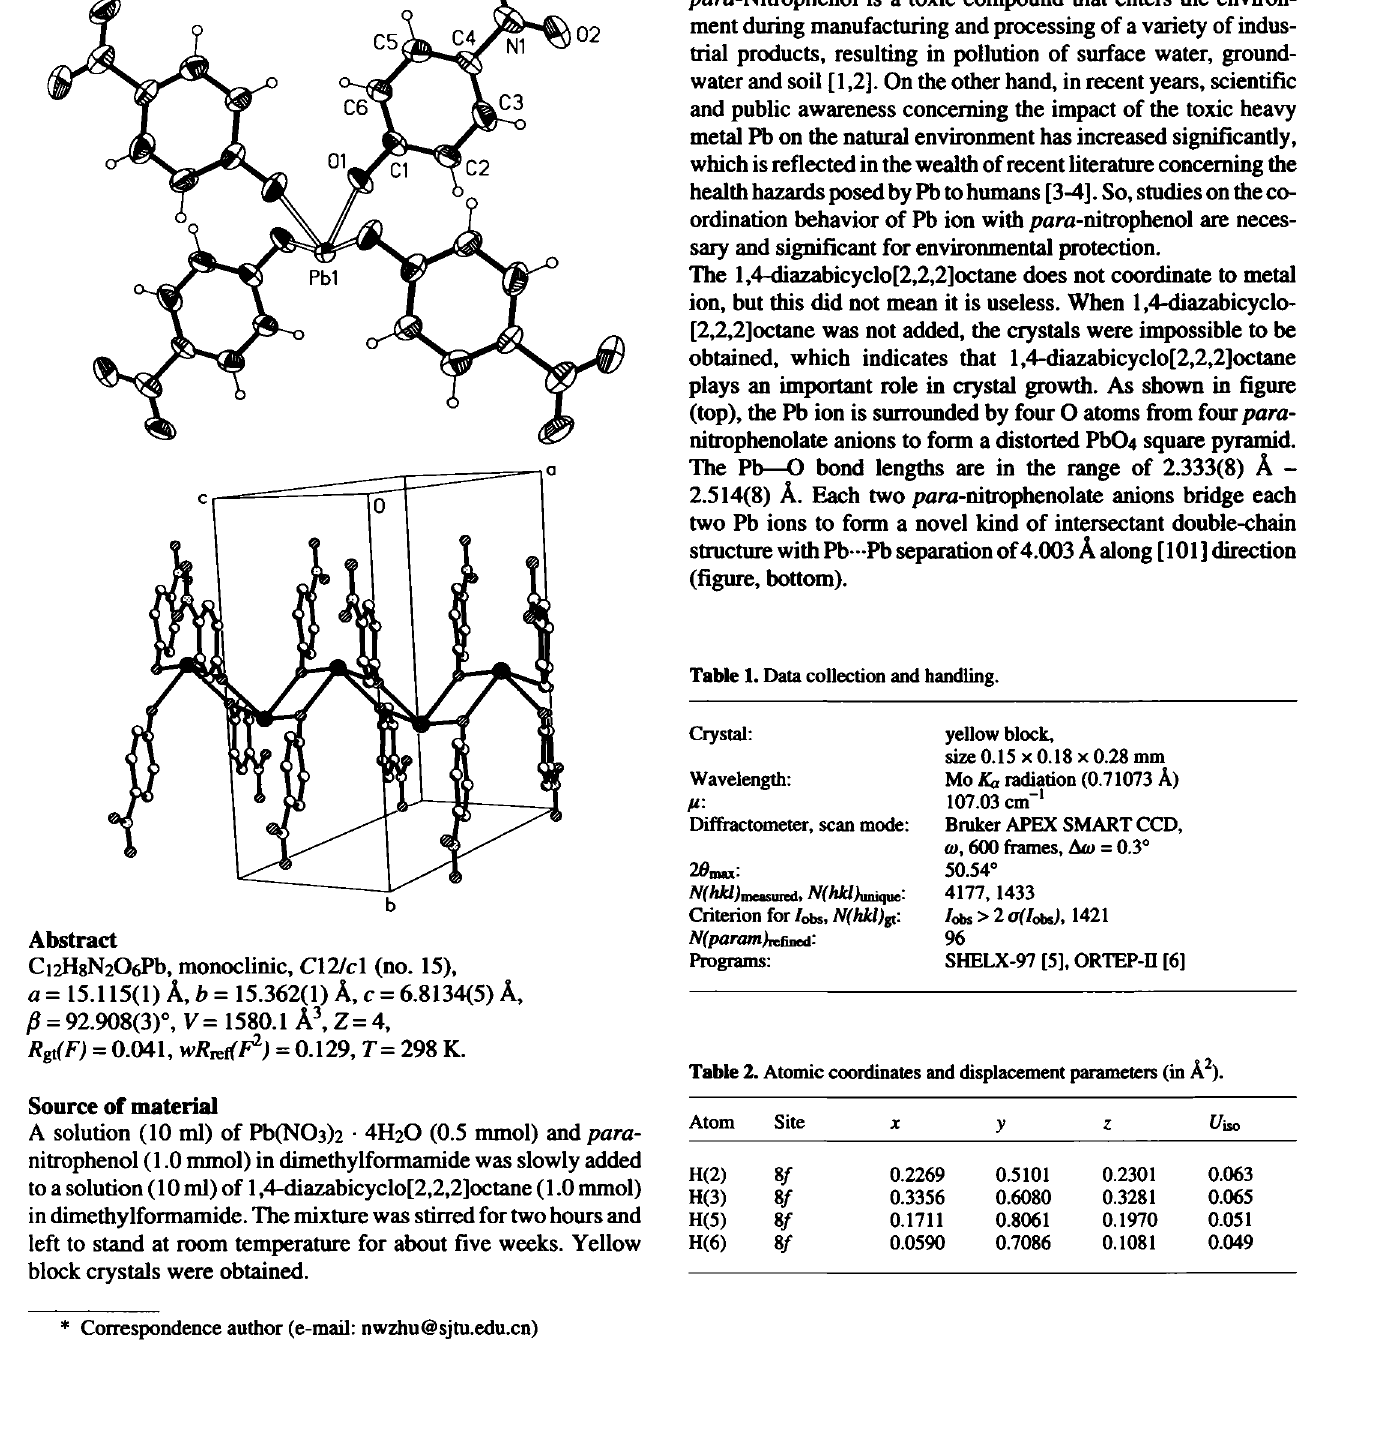
Table 2. Atomic coordinates and displacement parameters (in Â 2 ).